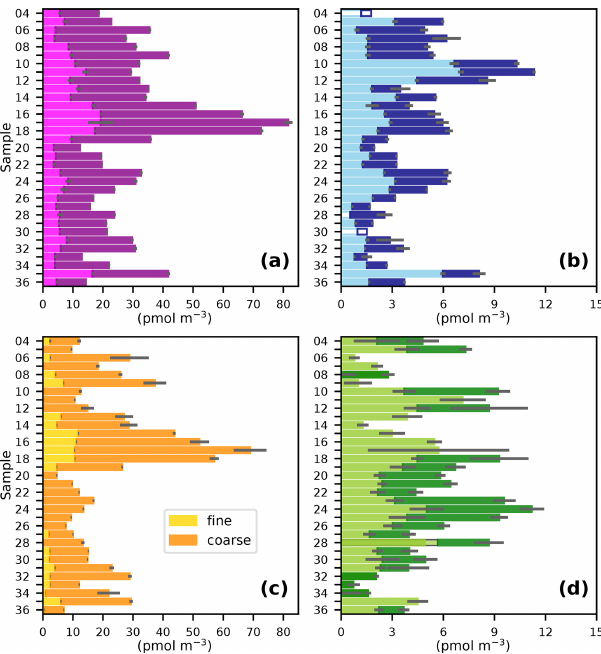
Figure 3. Fine ( < 1µm) and coarse ( > 1µm) aerosol concentrations of (a) TSI, (b) I − , (c) IO − , and (d) SOI during the AMT21 cruise. 3 Details are as for Fig.